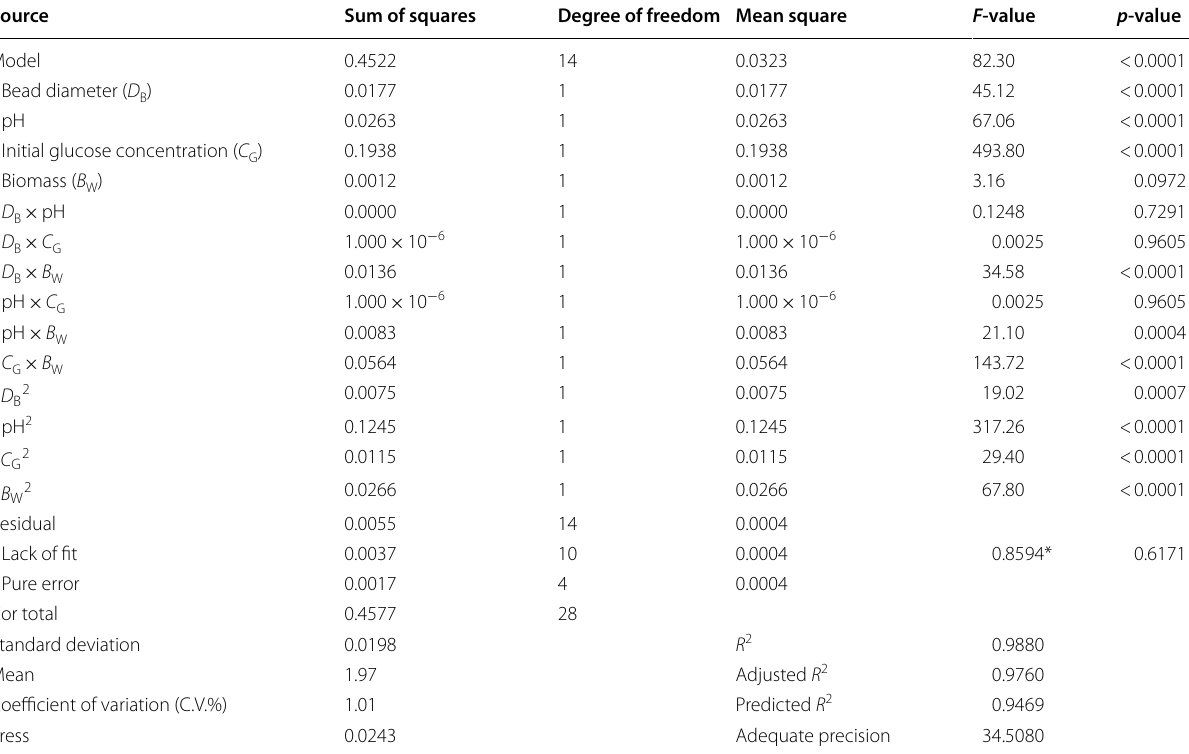
Table 5 ANOVA for LA productivity by immobilized L. pentosus ATCC 8041